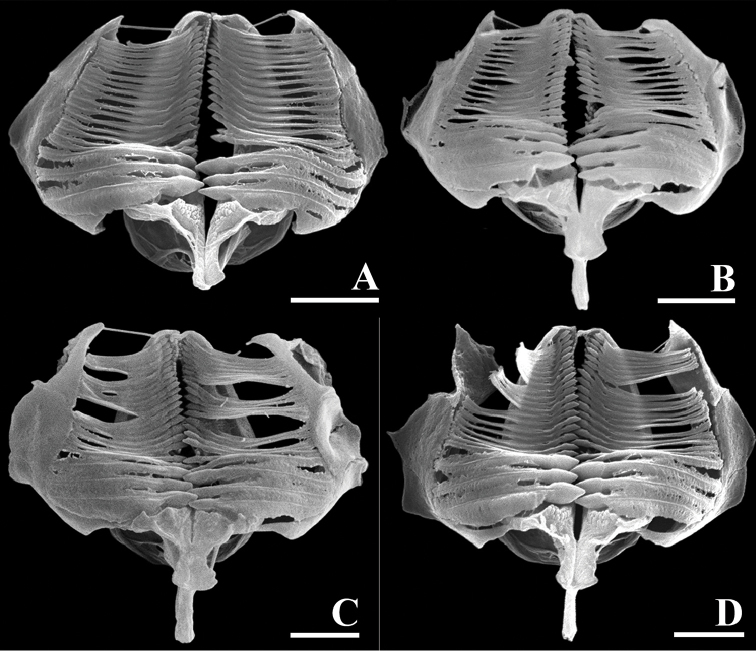
SEM photographs of trophi (frontal view). ALimniaslenis sp. n. BLimniasnovemceras sp. n. CLimniasmelicerta SH DLimniasmelicerta LH. Scale bars: 5 µm.